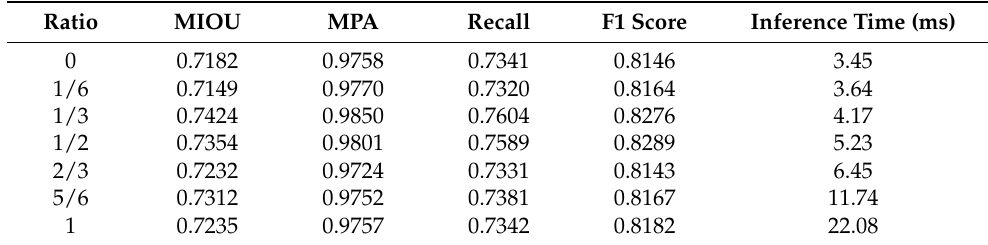
Table 1. Comparison of experimental results for different ratios of REI modules in the baseline model.